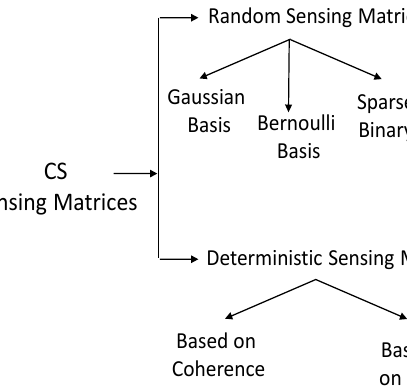
Figure 2. Classification of sensing